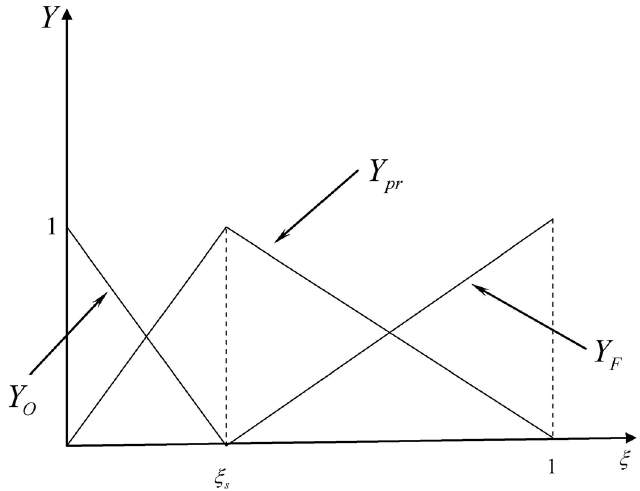
Figure 7. Reactant profiles in mixture fraction space under fast chemistry